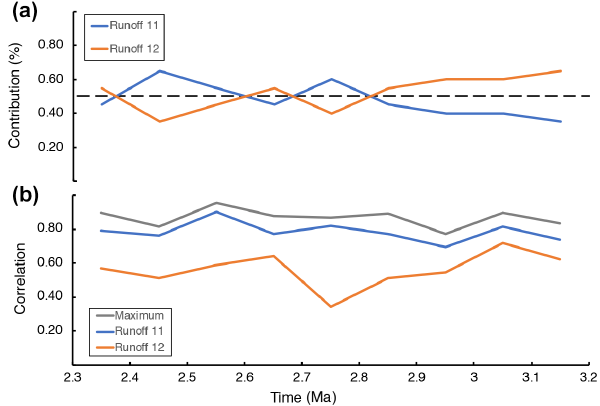
Figure 10. Transient contribution of runoff from grid boxes 11 and 12 to Mediterranean dust input. For each time window of 100kyr, all combinations of the two grid boxes (as in Fig. 7) are correlated with the Ti / Al record of Site 967. (a) The contribution of both grid boxes (blue for runoff 11 and orange for runoff 12) is given, cor- responding to the maximum correlation within that time frame, as shown by the grey line in panel (b) . (b) The maximum correlation within each 100kyr time window is given in grey, corresponding to the contributions shown in panel (a) . Correlation of the individual grid boxes is given in blue for runoff 11 and in orange for runoff